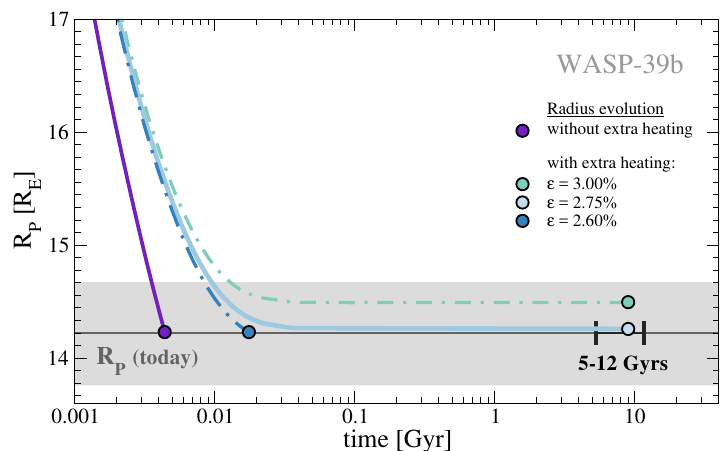
Figure 5. Radius evolution for WASP-39b with (bluish) and without (purple) extra heating. The planet stays hot and inflated for several Gyrs as the additional heating (cid:101) prevents further contraction.